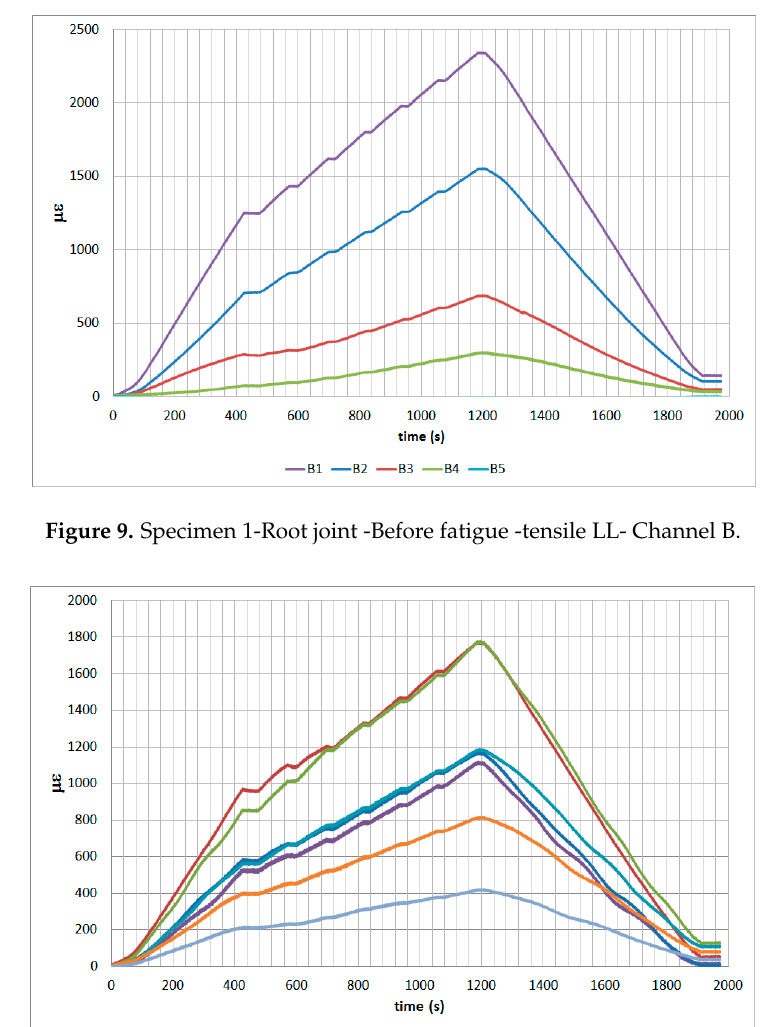
Figure 8. Specimen 1-Root joint -Before fatigue -tensile LL- Channel A.